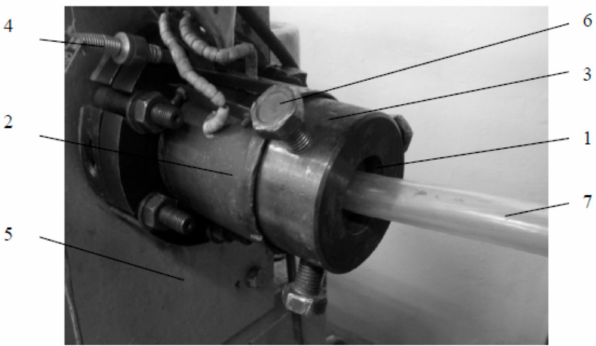
Figure 1. Extrusion head used in the study: 1—head nozzle body, 2—ring heater, 3—head body, 4—temperature sensor, 5—extruder casing fragment, 6—nozzle body adjustment screws, 7—filling